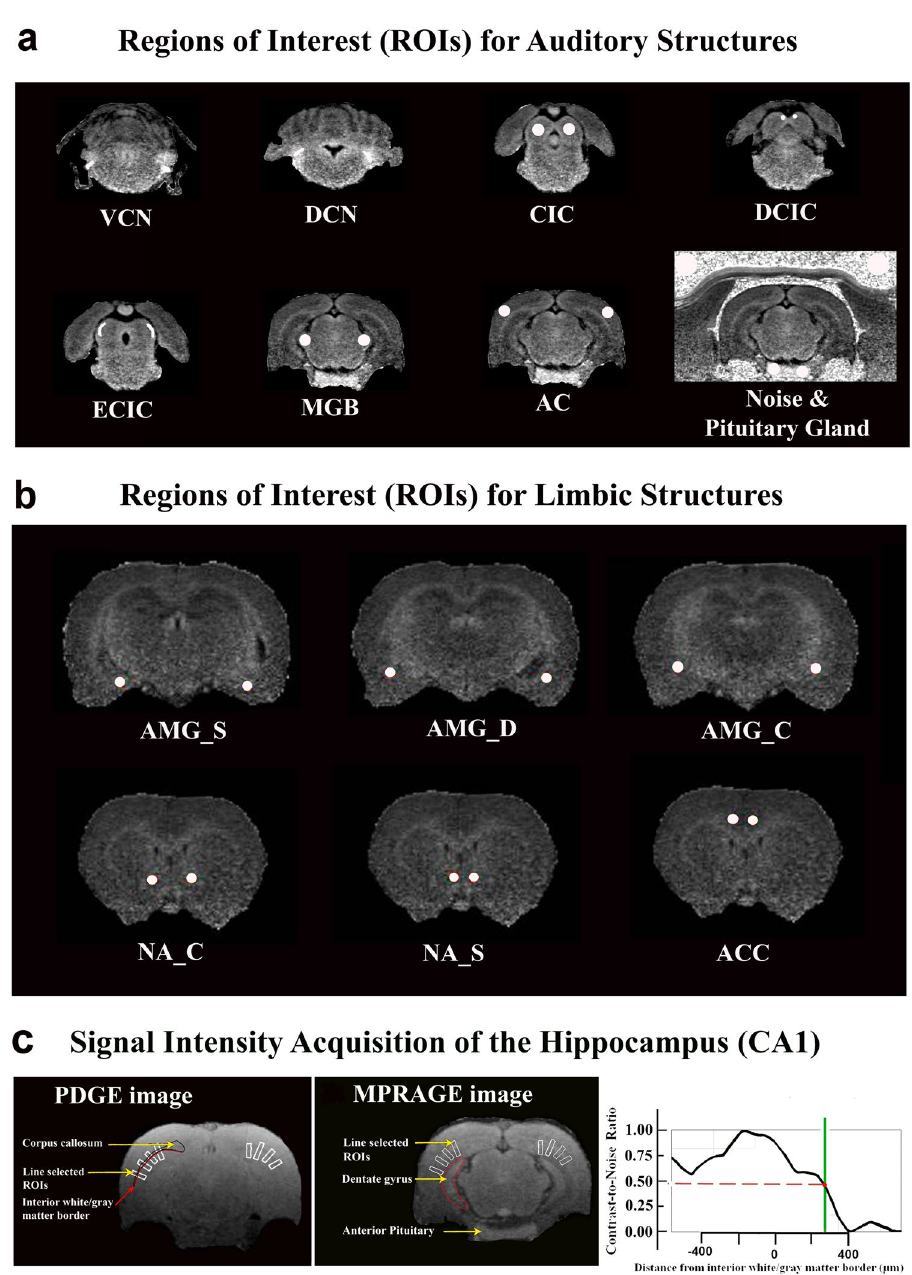
Figure 5. Representative ROI placements. ( a ) To measure manganese uptake in the auditory system, ROIs were placed in the left and right dorsal cochlear nuclei (DCNs), ventral cochlear nuclei (VCNs), central nuclei of the inferior colliculus (CICs), external cortices of the inferior colliculus (ECICs), dorsal cortices of the inferior colliculus (DCIC), medial geniculate bodies (MGBs), and auditory cortices (ACs). ROIs were also placed in the left and right anterior pituitary glands and nearby noise. ( b ) To measure the limbic system, ROIs were placed in the left and right centromedial amygdala (AMG C ), the superficial/cortical-like amygdala (AMG S ), deep/ basolateral amygdala complex (AMG D ), nucleus accumbens core (NA C ) and shell (NA S ), and anterior cingulate cortices (ACCs). ( c ) To measure the hippocampus, four rectangular bands (white color) were first placed onto the PDGE image. They were then copied onto the corresponding MPRAGE